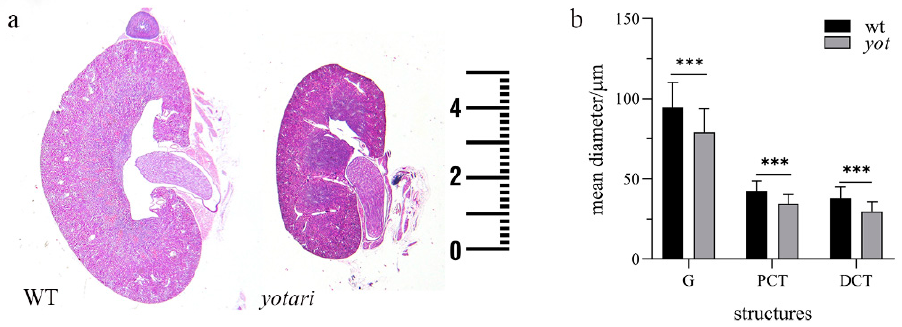
Figure 1. Light microscopy examination of the wild-type and yotari kidneys at 4P. ( a ) Comparison of wild-type (left) and yotari (right) kidney size. ( b ) Mean diameters of glomeruli (G), convoluted tubules (PCT) and distal convoluted tubules (DCT) in the kidneys of yotari animals were significantly smaller compared to wild-type animals. Data presented as the mean ± SD (vertical line). Significant differences were indicated by *** p < 0.0001 (two-tailed t -test). Per each sample, 100 PCTs, DCTs, and glomeruli were assessed. Scale bar is 1 mm, refers to images in ( a ).